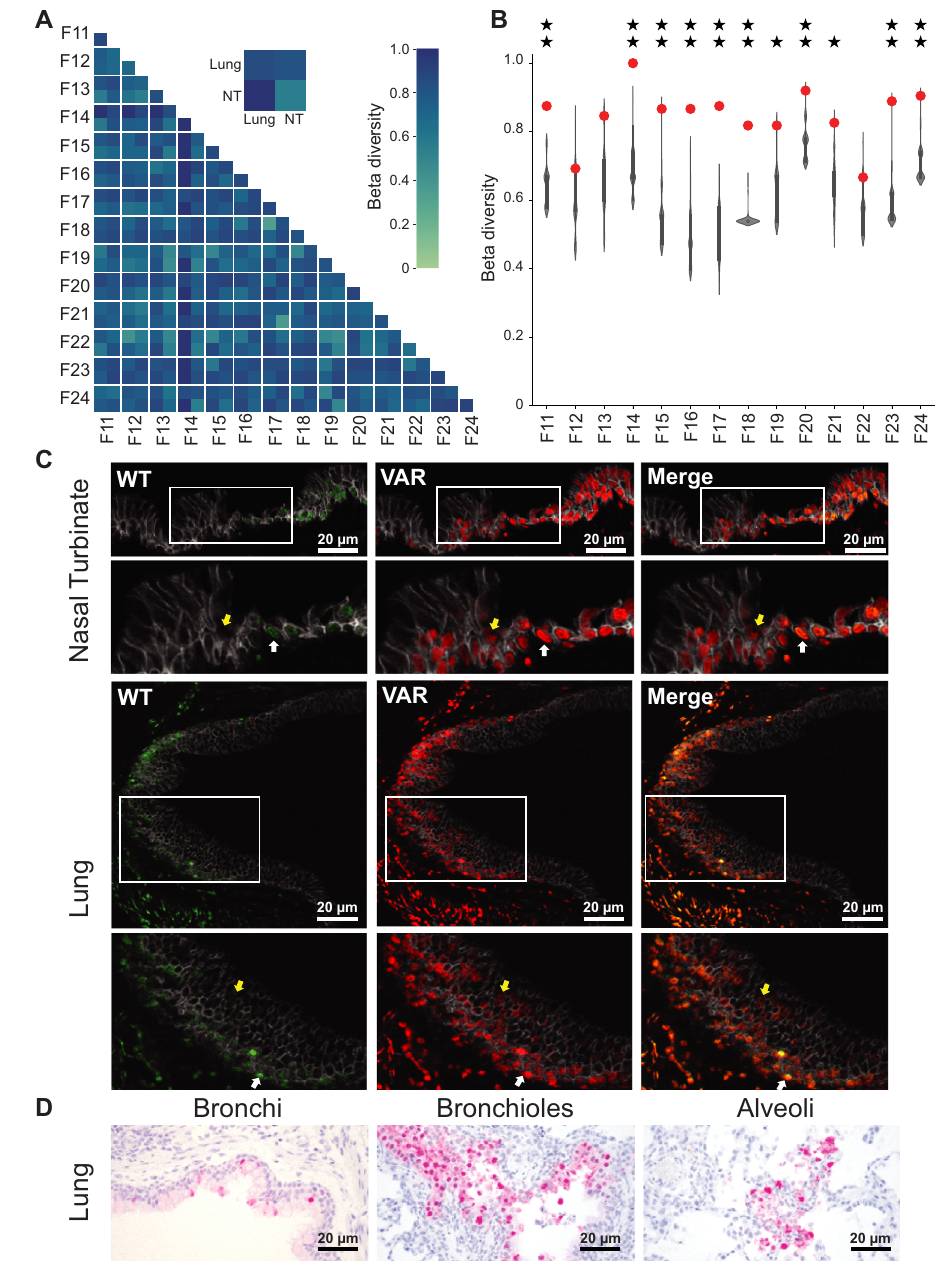
Fig. 3 | Reassortant viralpopulationsinthe ferret upperand lower respiratory tracts are distinct. Heat map showing normalized beta diversity of viral popula- tions in ferret lung and nasal turbinates (NT) ( A ). The inset shows a representative comparison between the tissues of ferrets F23 and F21, to indicate the position of NT and lung within the matrix. Normalized beta diversity is plotted in B with observed results (colored points) overlaid on the distribution of simulated data (gray violins) ( n =1000 simulations per ferret). Data are presented as violin plots featuring a box plot. Data are presented as violin plots featuring a box plot. The boundsoftheboxshowtheinterquartilerangeandthecenteroftheboxshowsthe 50th percentile. Whiskers indicate 1.5 times the interquartile range and contain ∼ 99% ofthedataforanormaldistribution.Theboundsoftheviolinplotsindicate theminimaandmaximaoftheentiredataset.Onestarindicatesthatobserveddata